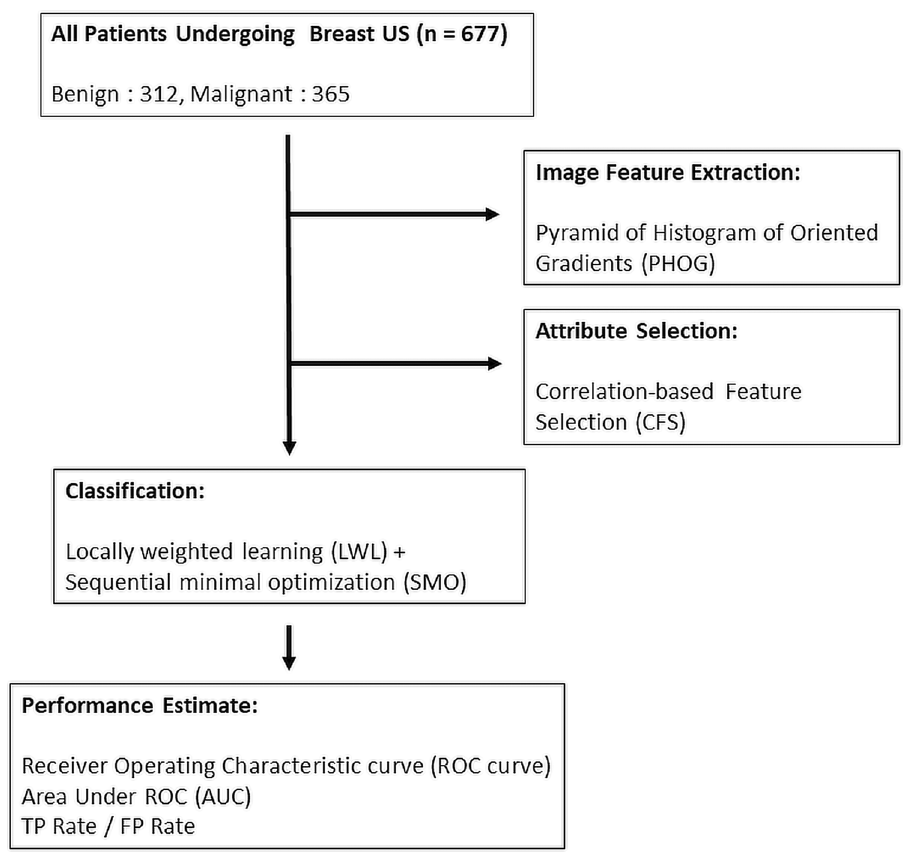
Figure 1. Flowchart of patient enrolment and the data analysis